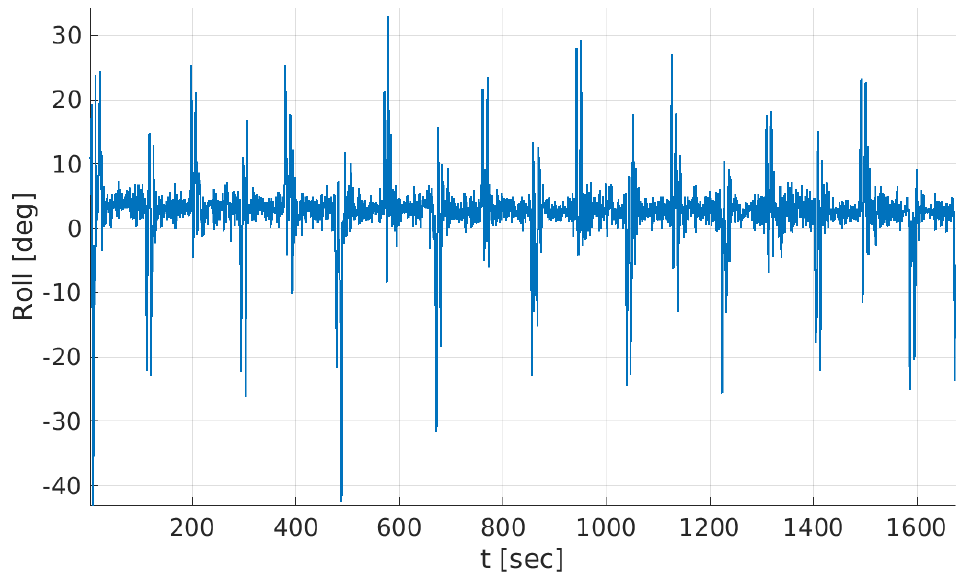
Figure 29. Vehicle’s roll angle during the mission, employing the SPARUS II configuration. The “spikes” are the moments of turns.